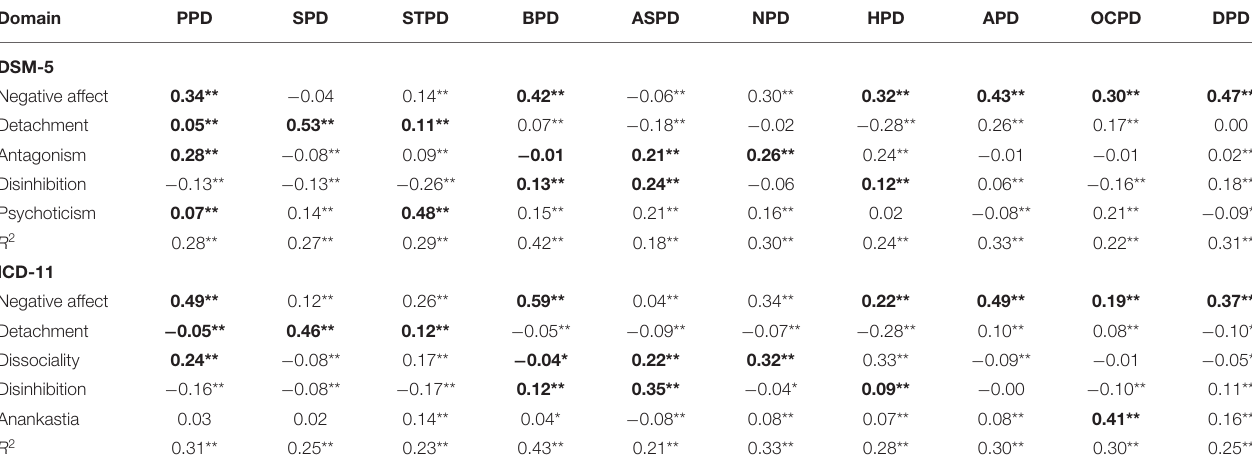
TABLE 7 | Multiple regression coefficients for DSM-5 and ICD-11 domains as predictors of 10 PD.